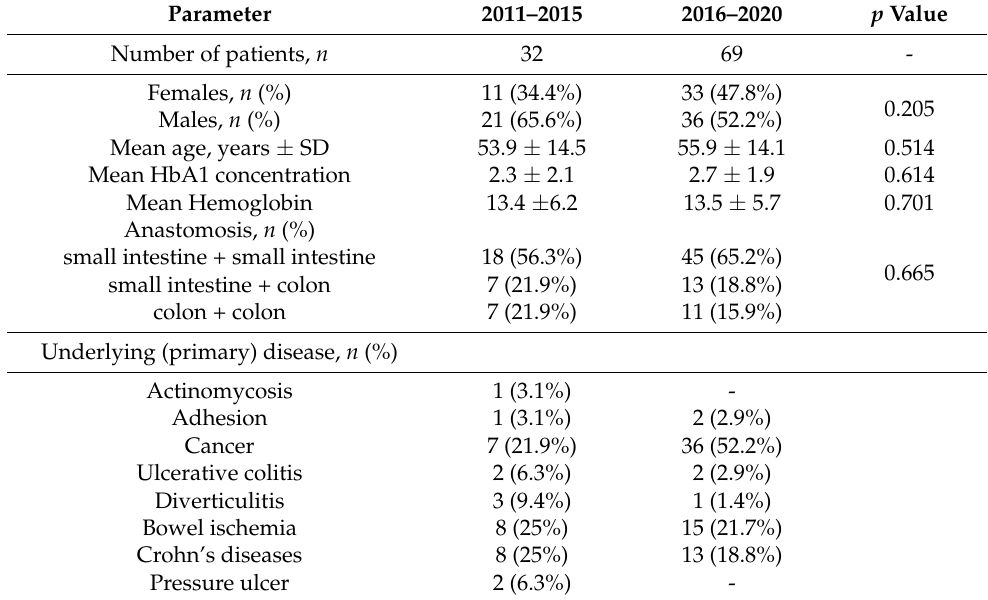
Table 2. Demographic analysis of